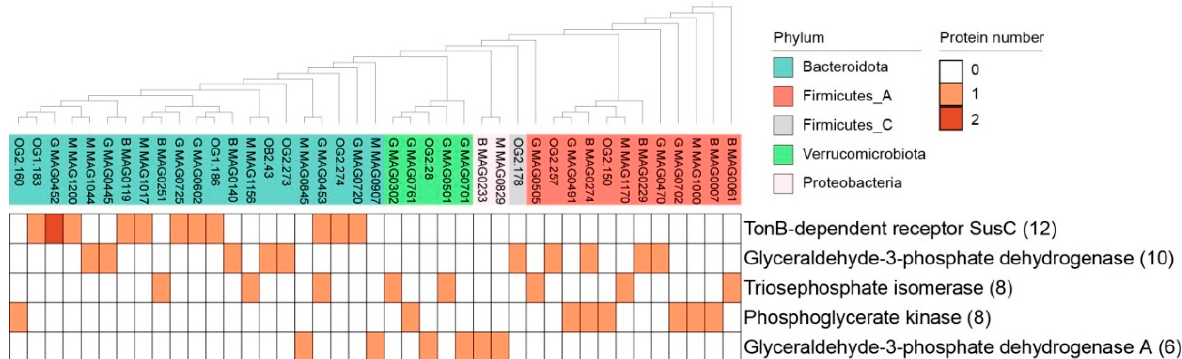
Figure 4. Taxonomic origins and annotations of representative bacterial-derived extracellular proteins. The heat map represents the number of identified TonB-dependent receptor SusC and intracellular/surface moonlighting proteins (ISMPs) in each bacterial MAG. The upper part is a maximum likelihood phylogenetic tree of bacterial MAGs based on 122 single-copy genes, the colored background represents the different phylum of MAGs.